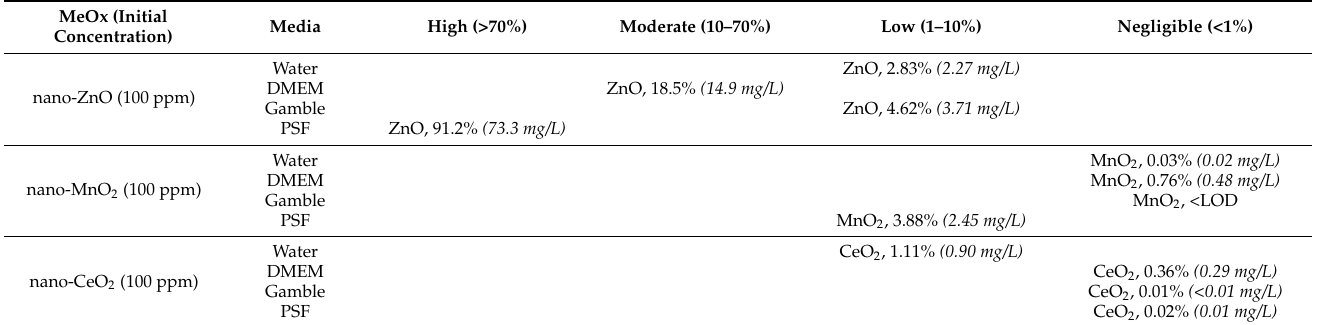
Table 3. Grouping of MeOx ENMs based on dissolution results in PSF, Gamble, DMEM, and water (24 h of incubation, 100 mg/L initial concentration) using the screening criteria/categorisation approach from OECD ENV/JM/MONO (2015)44. (<LOD = below the limit of